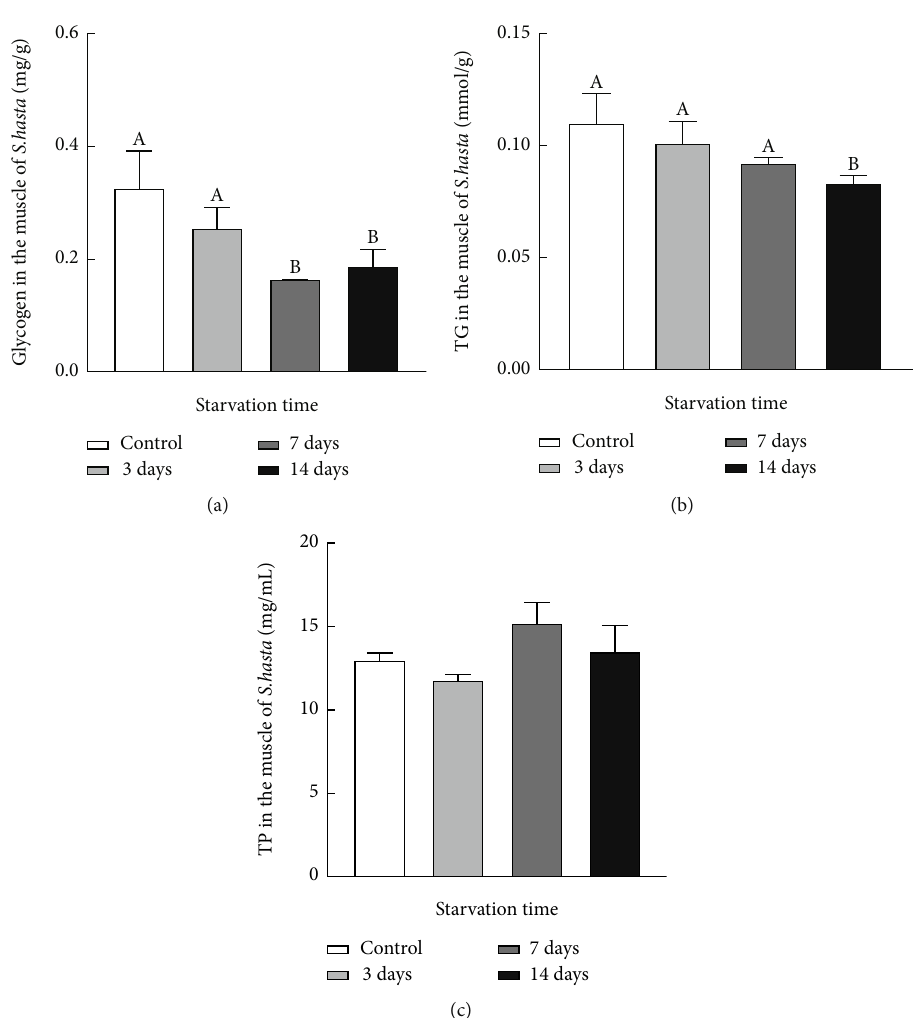
Figure 1: E ff ects of starvation on glycogen, triglyceride, and protein content in the muscle of Synechogobius hasta . Concentrations of glycogen (a), total triglyceride (b), and total protein (c) in the muscle of S. hasta subjected to di ff erent starvation periods. All values were represented as means ± SD ( n = 5 ) and analyzed using one-way ANOVA. Di ff erent uppercase letters denote signi fi cant di ff erences ( P < 0 : 05